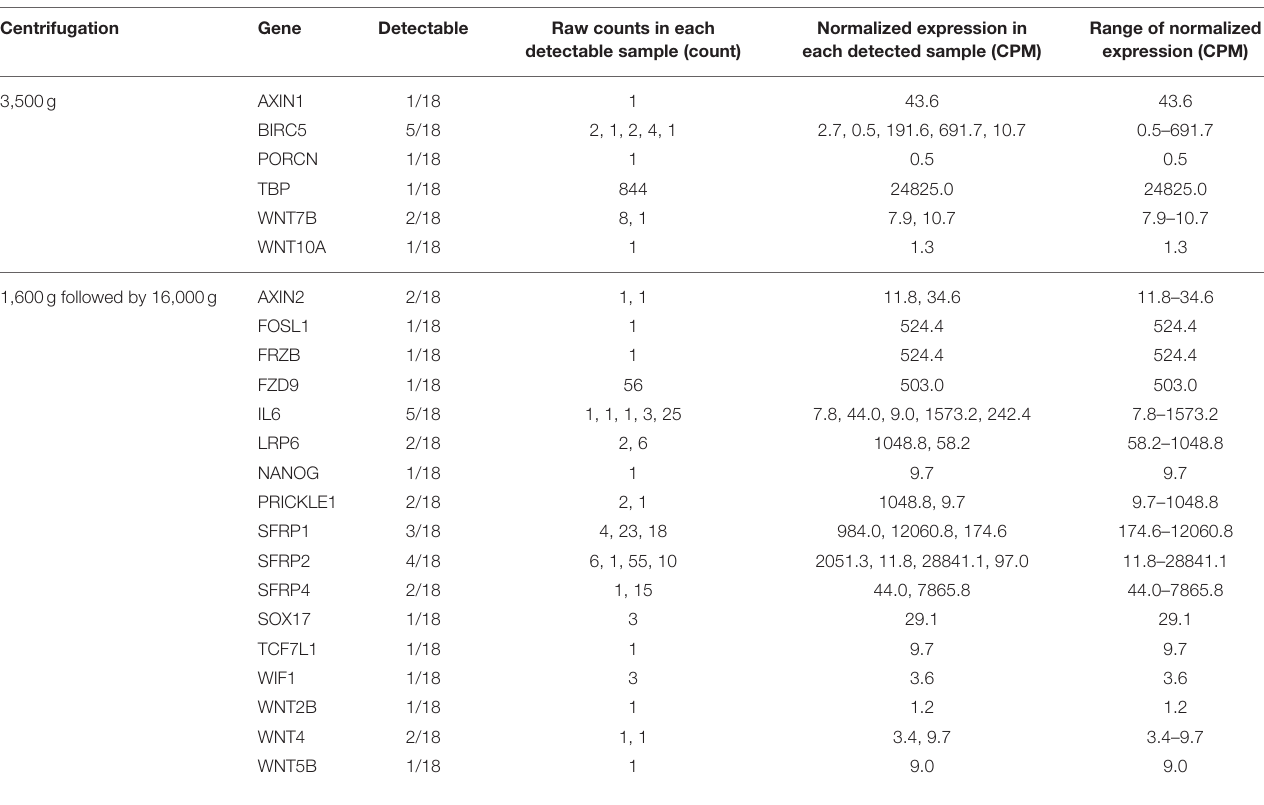
TABLE 2 | The expression of genes detected only in one of two centrifugal forces. Centrifugation Gene